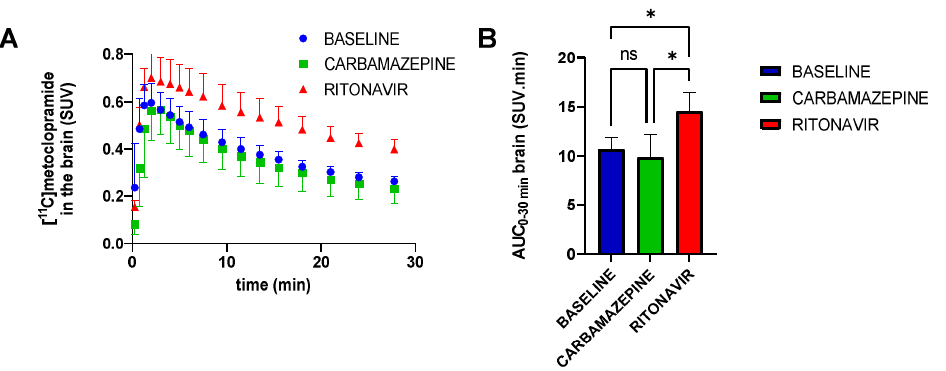
Figure 2. Whole-brain time–activity curves ( A ) and area under the whole brain curve from 0 to 30 min (AUC 0–30 min , ( B ) for groups without (baseline) and with pretreatment with carbamazepine or ritonavir. Data are reported as mean ± S.D with n = 4 per condition. ns = not significant, * p < 0.05 (one-factor ANOVA and Tukey’s post hoc test for multiple comparisons).